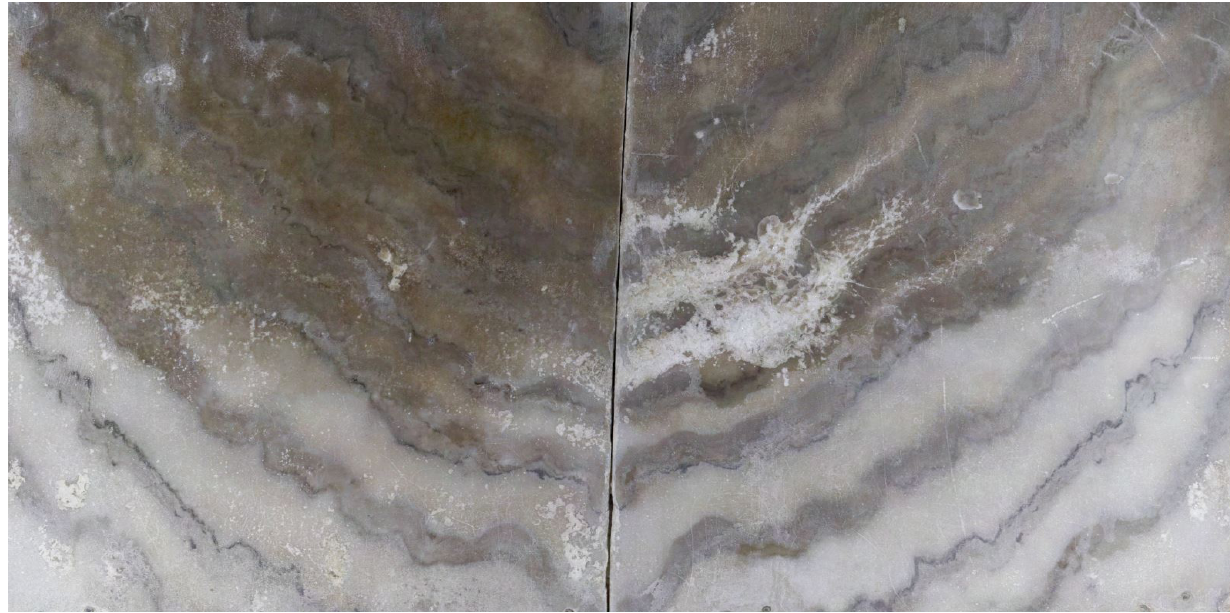
Figure 4. San Marco Basilica, western wall of the southern transept, RGB